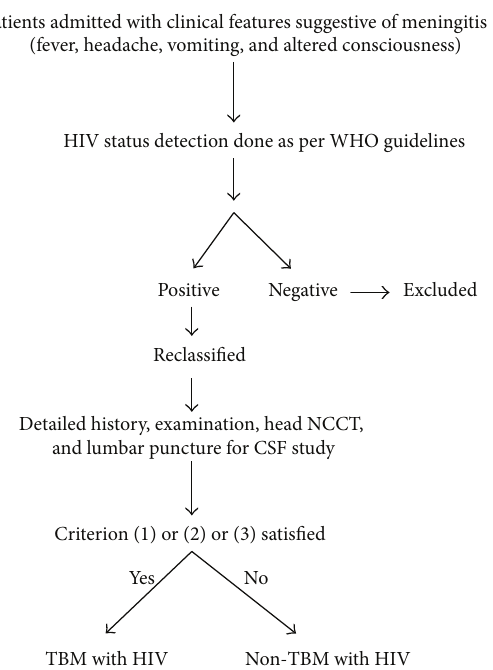
Figure 1: Flow chart showing recruitment of patients.